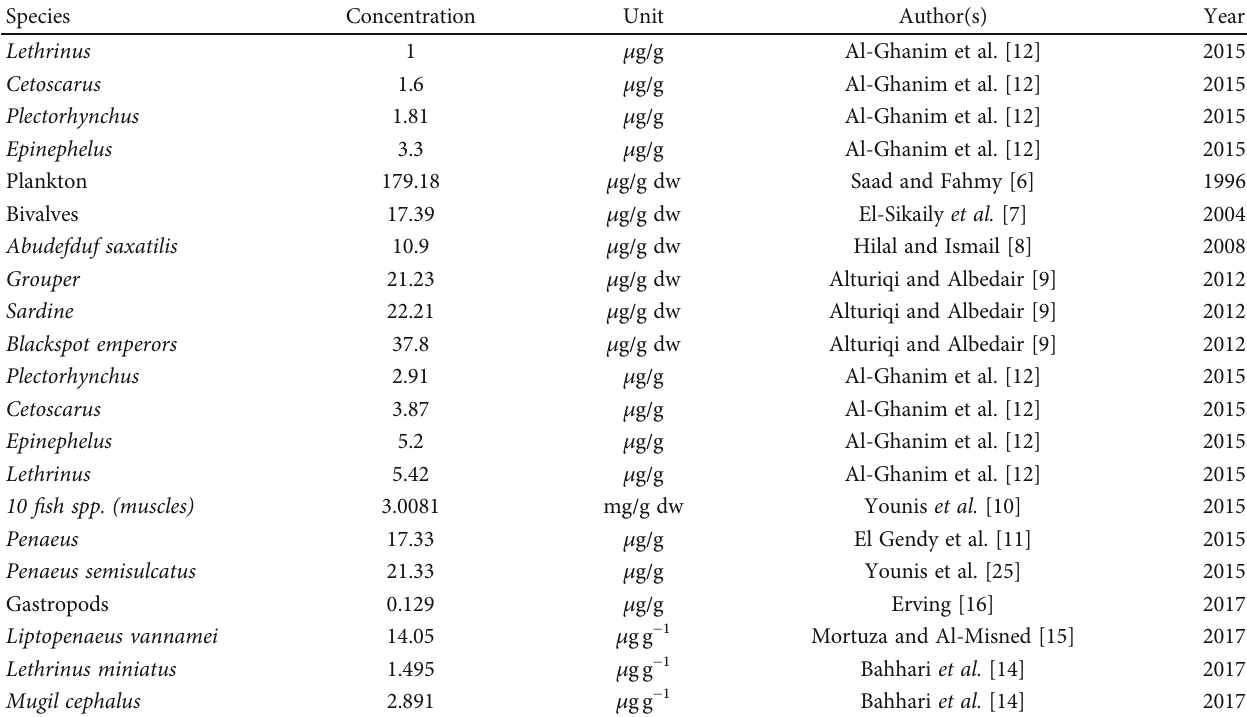
Table 4: Bioaccumulation of selenium and zinc reported from the Red